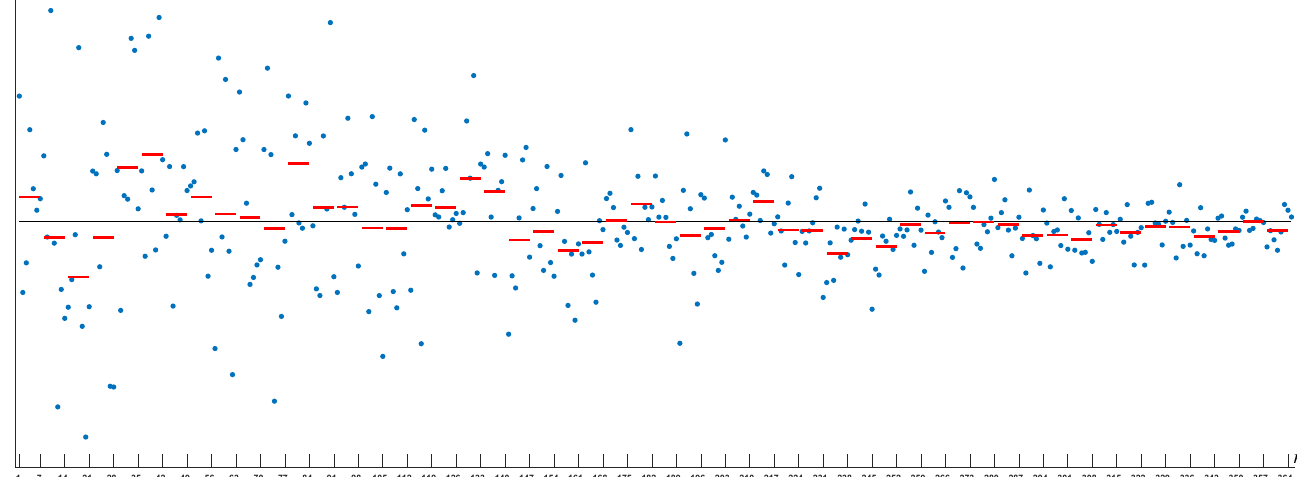
Fig. 1. A visual explanation of the principle of considering the expected power approximation to progress more stable. Each dot representing a day of measurements is an expected power by (11). The length of the measurements is a year, so there are 365 dots overall. The series of seven subsequent m ’s (week by week) is used here. The unknown ground truth mathematical expectation is shown as a horizontal line. The week-length expected values are shown as short horizontal lines. The variance is apparently decreasing, and the short lines are “sticking” to the expectation. The sufficiency acceptable level is not shown,